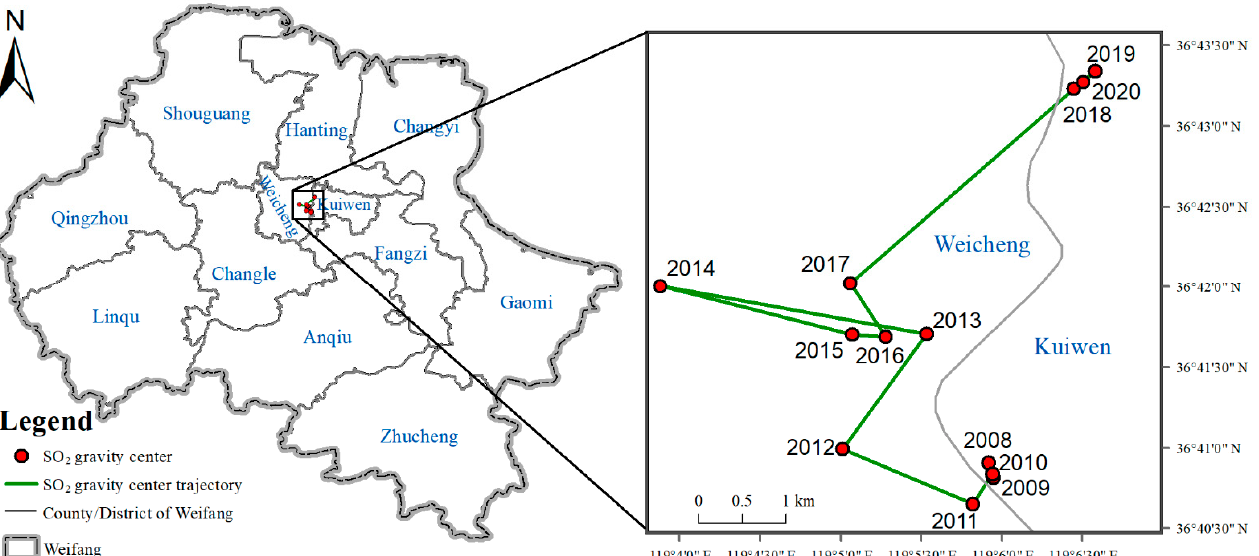
Figure 10. SO 2 center of gravity from 2008 to 2020.